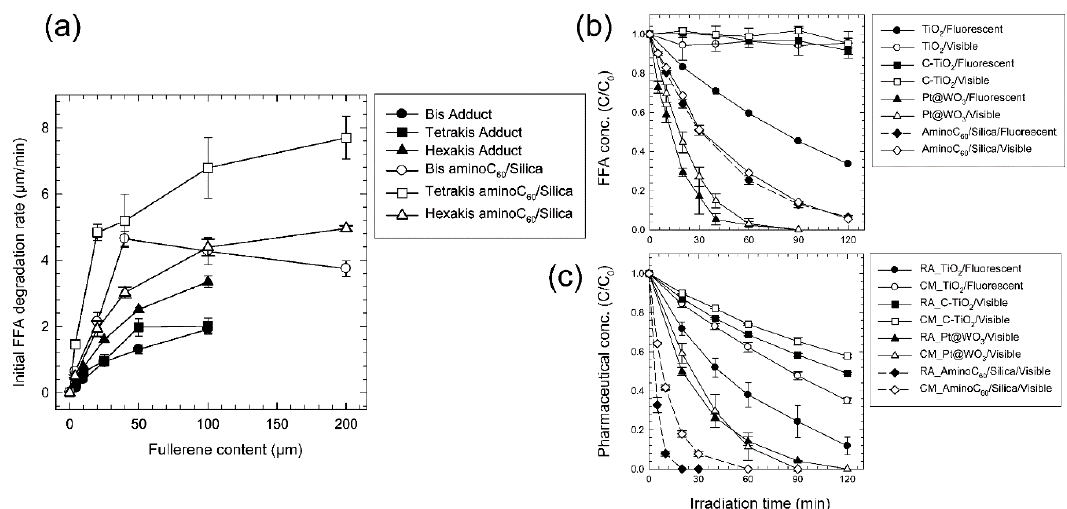
Figure 10. ( a ) Photochemical furfuryl alcohol (FFA) degradation (measuring photosensitized 1 O 2 production) by aminofullerenes and aminofullerene / silica composites. Comparisons of degradation efficiency towards furfuryl alcohol ( b ) and ranitidine (RA) and cimetidine (CM) ( c ) by TiO 2 , carbon-doped TiO 2 (C-TiO 2 ), Pt@WO 3 and tetrakis aminoC 60 / silica. Reproduced with permission from Reference [140,143]. Copyright 2010, 2011, ACS.